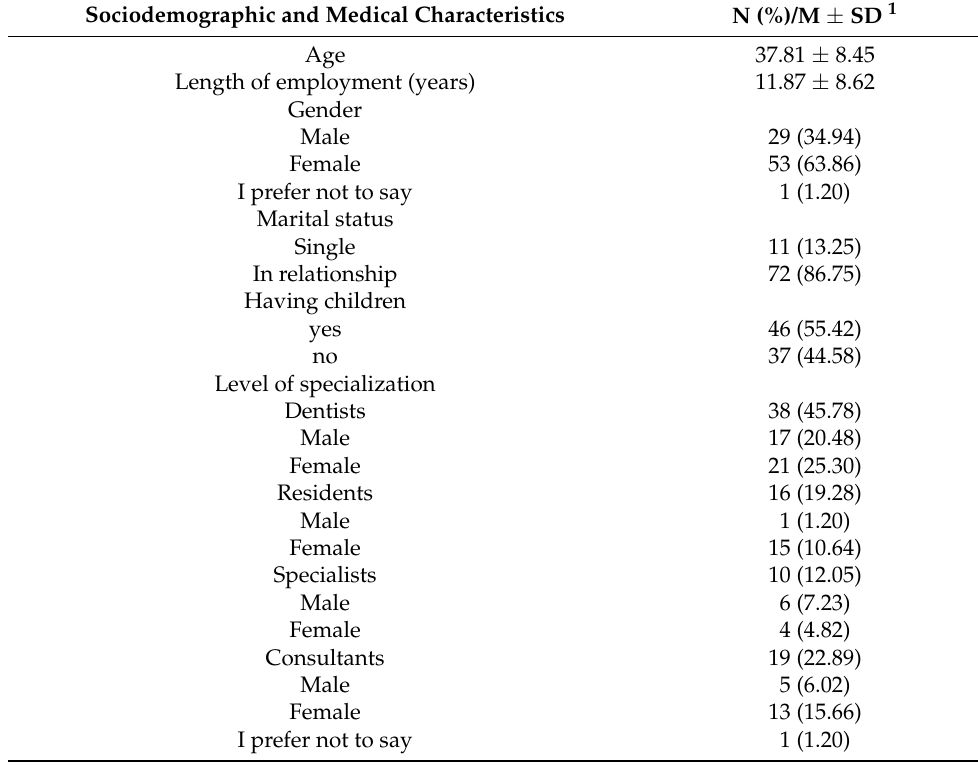
Figure 1. Study profile. Other sociodemographic data were collected (age, gender, length of employment, number of children, marital status, and teaching activity). The sociodemographic charac- teristics are presented in Table 1. Table 1. The distribution of respondents considering the gender and professional level 1